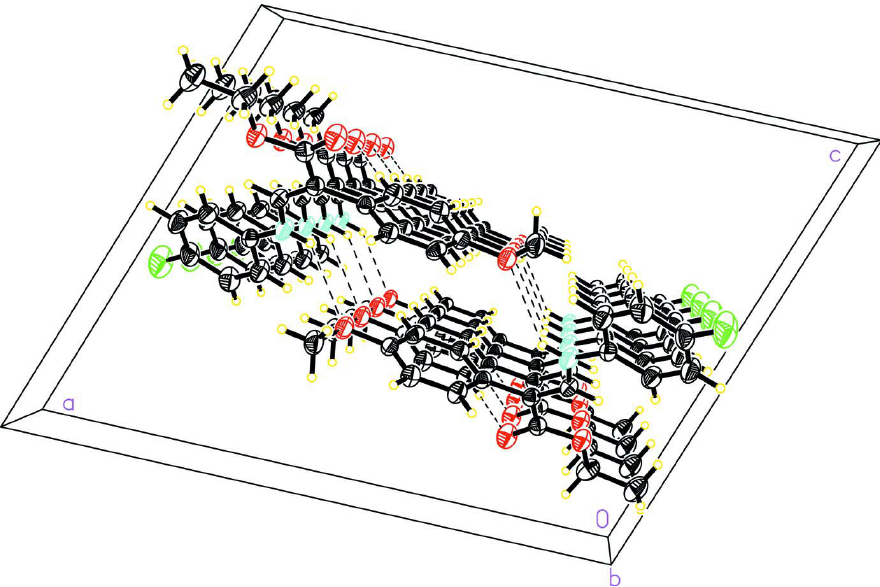
A partial packing diagram of the title compound showing the ribbons connected by C—H···O and N—H···O hydrogen bonds (indicated by dashed lines), viewed along the b